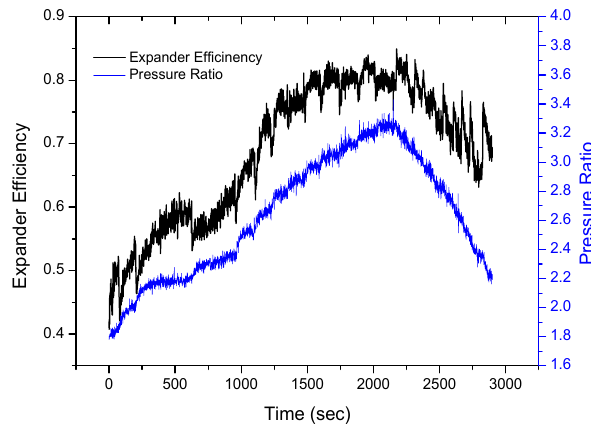
Figure 15. Pressure ratio and expander efficiency.